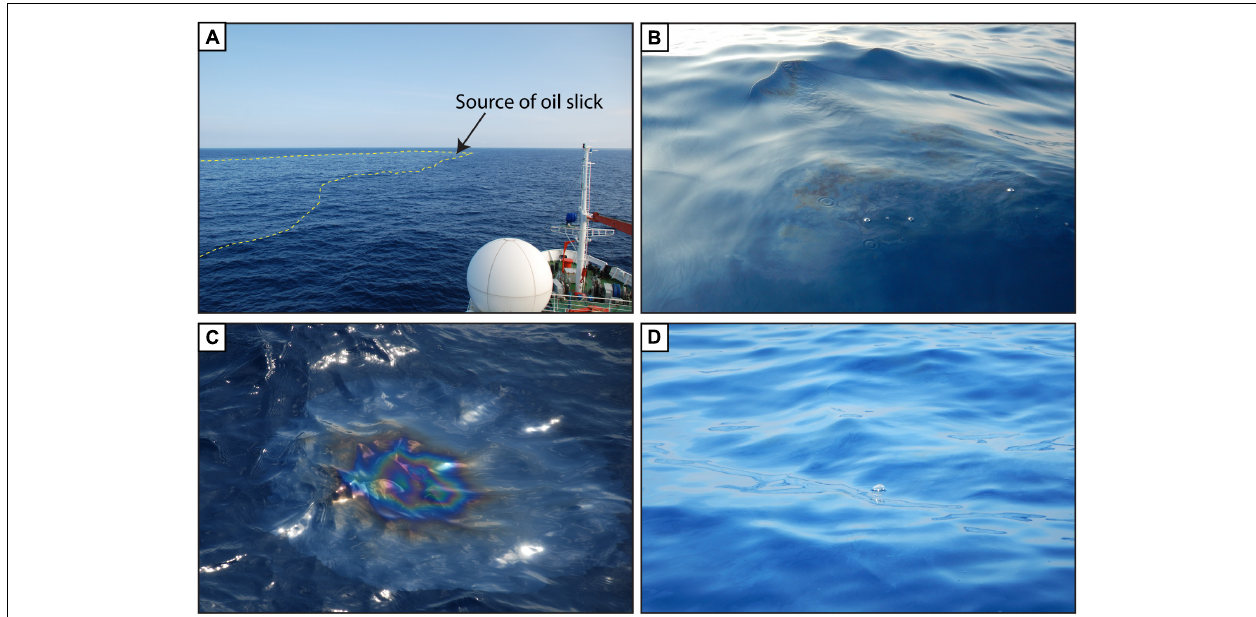
FIGURE 8 | Sea surface pictures taken from the vessel during METEOR cruise M114 in March 2015. (A) An oil slick was visible due to the smoothing of the sea surface. (B) Oil and gas bubbles were observed at that location and interpreted to define the area where hydrocarbons reach the sea-air interface. (C) Photograph taken shortly after an oil bubble reached the sea surface and oil spreads in a circular pattern. (D) A gas bubble reaching the sea surface shortly before bursting and releasing its gas content into the atmosphere.